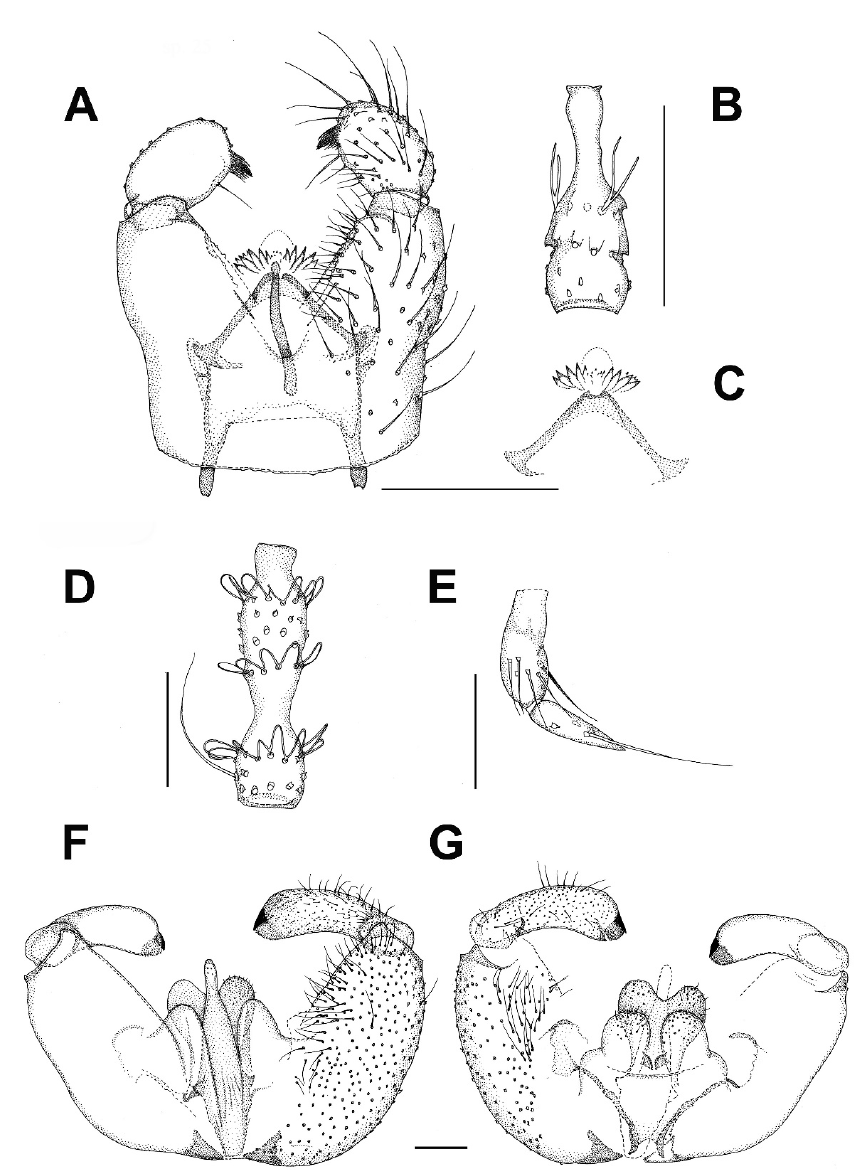
Figure 5. Catocha shengfengi sp. nov. (holotype): ( A ) ventral view, ( B ) fourth flagellomere, ( C ) tegmen with associated structures in dorsal view. Planetella taiwanensis sp. nov. (holotype): ( D ) fourth flagellomere, ( E ) maxillary palpus in lateral view, ( F ) male terminalia in ventral view, ( G ) male terminalia in dorsal view. Scale bars 0.1 mm.